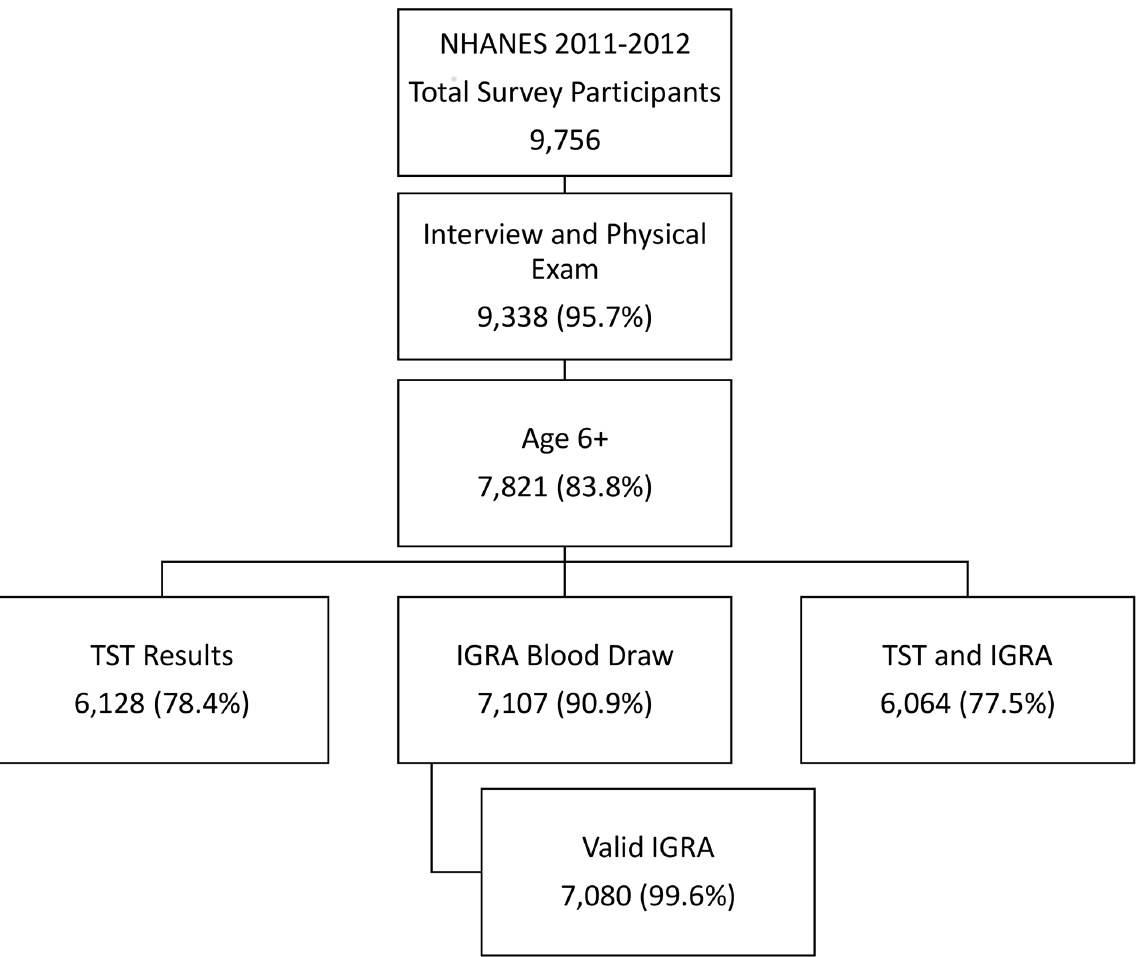
Fig 1. Flow chart illustrating participation in the 2011 – 2012 National Health and Nutrition Examination Survey, including total survey participants and number and percentage of survey participants who had tuberculin skin and interferon gamma release assay tests and results.